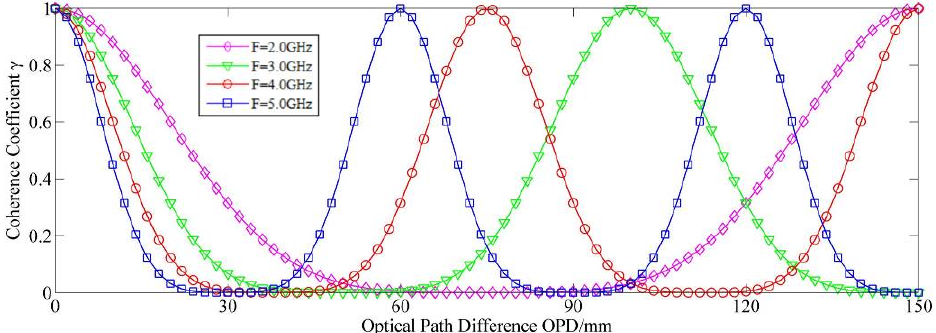
Figure1. Coherencecoe ffi cientwithrespecttoopticalpathdi ff erenceatdi ff erentmodulationfrequencies Figure 1. Coherence coefficient with respect to optical path difference at different modulation with 1.2 rad modulation frequencies with 1.2 rad modulation depth.